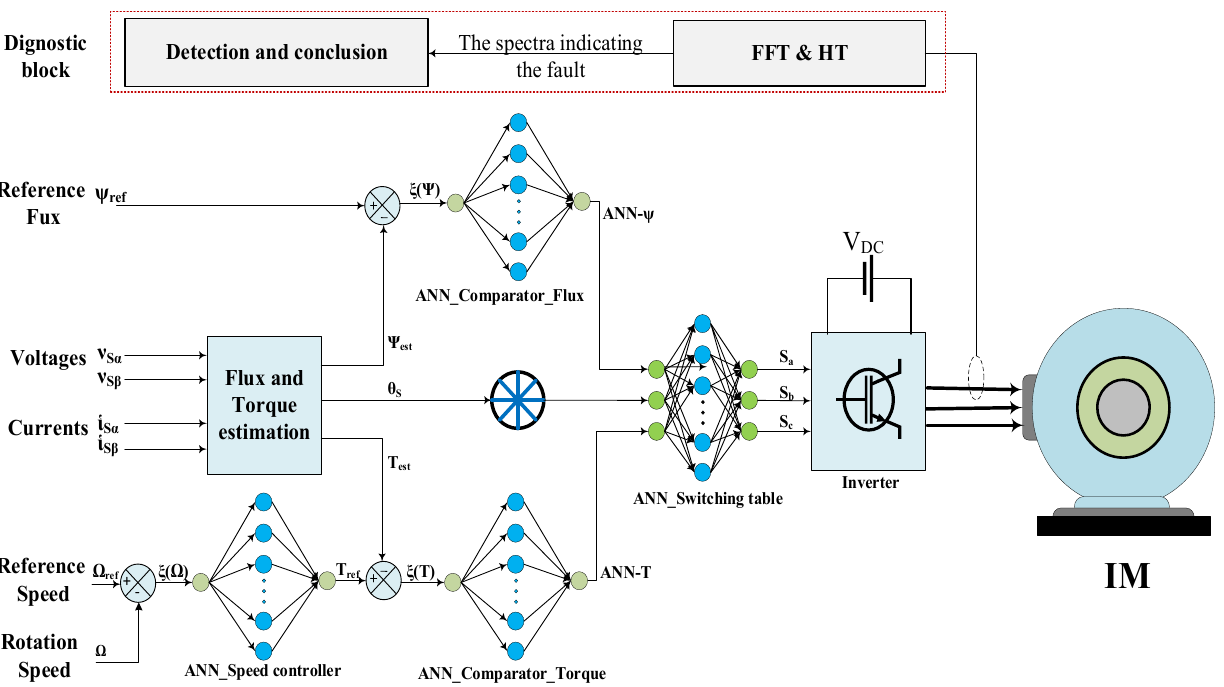
Figure 5. Global structure of ANN ‐ DTC for an induction motor, with diagnostic scheme.